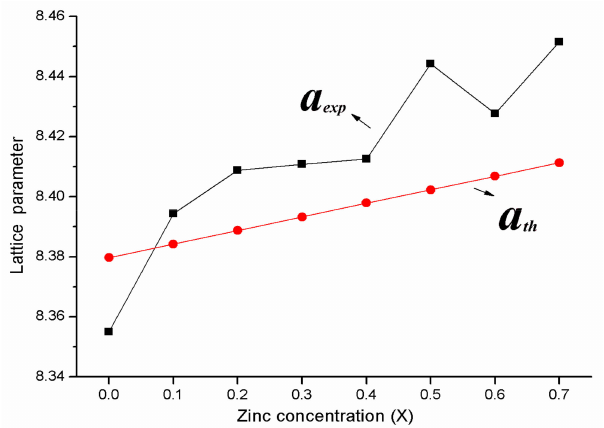
Figure 2. The variation of the theoretical and experimental lattice parameter for Co 1 − x Zn x Fe 2 O 4 ( x = 0–0.7).